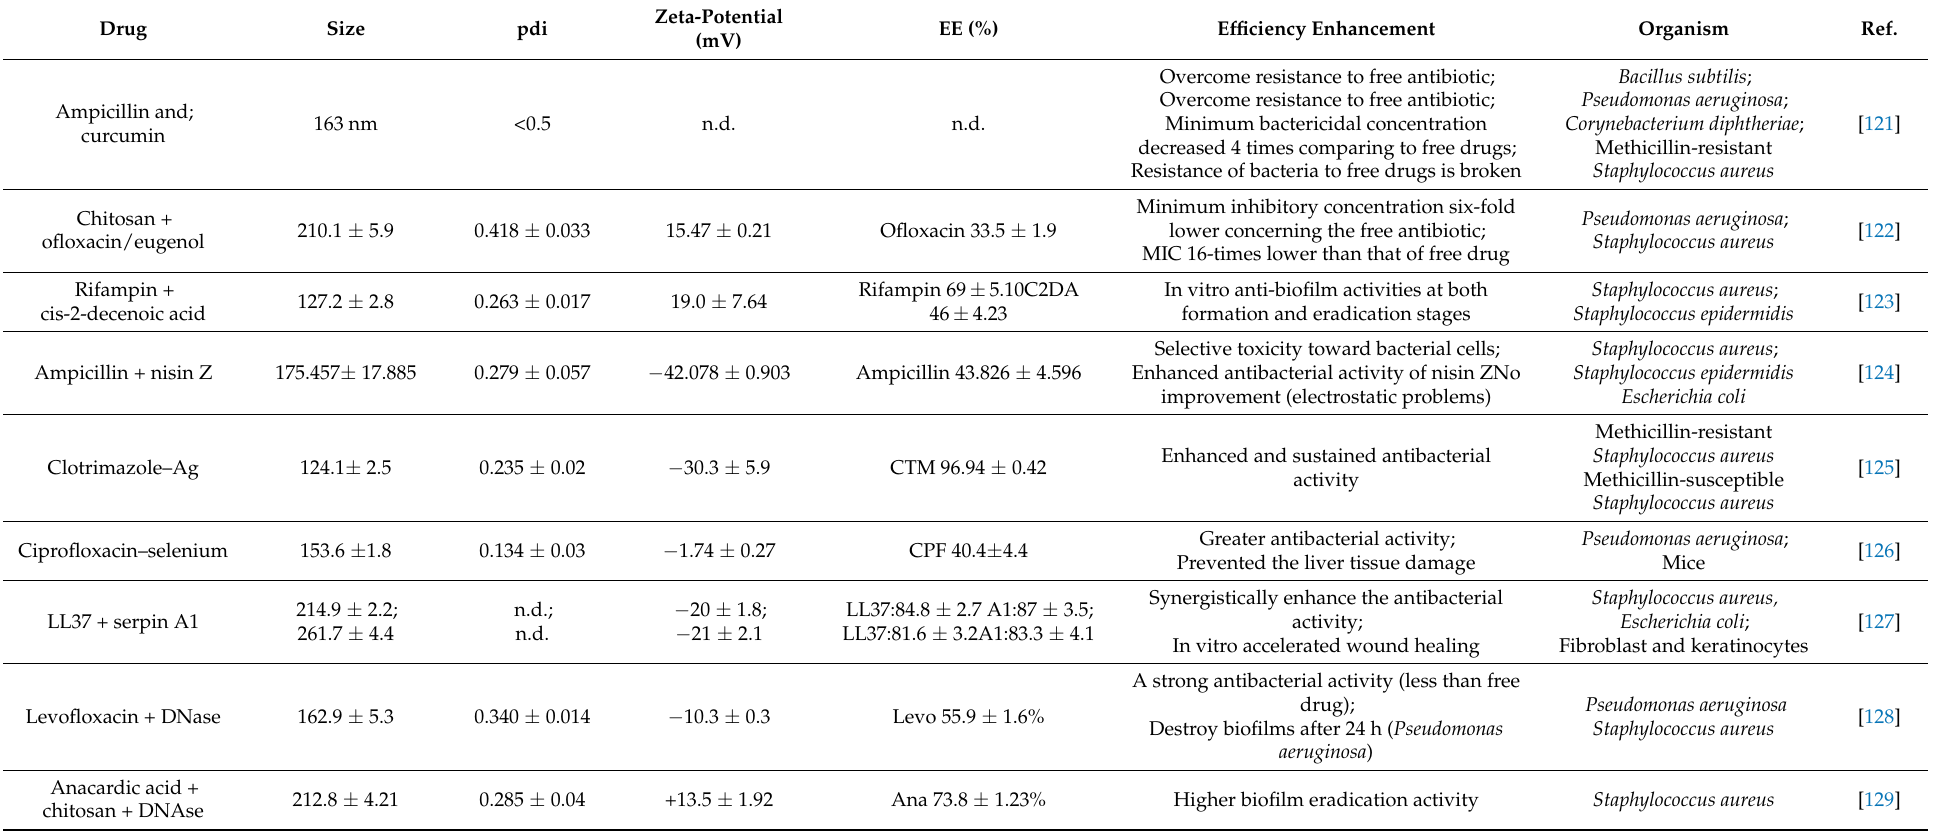
Table 2. Characteristics of SLNs formulations for combined